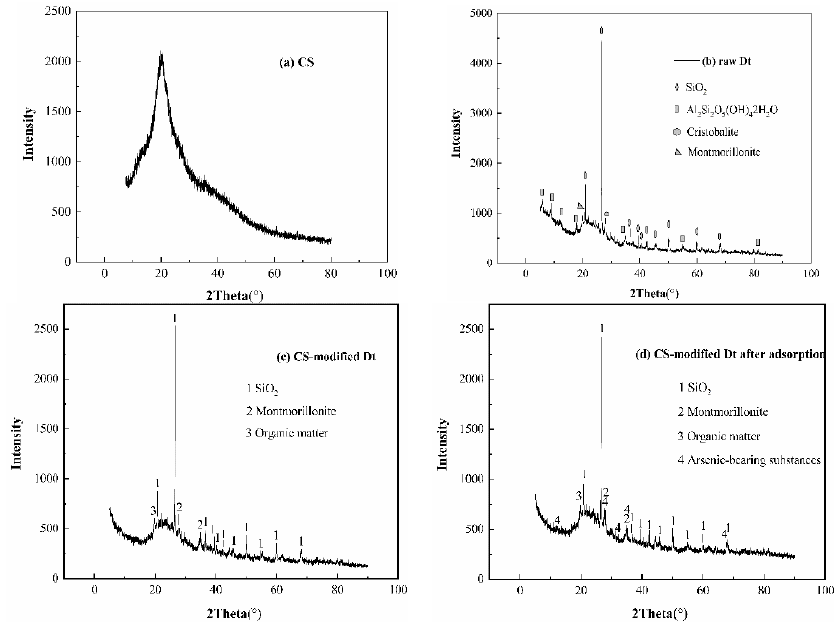
Figure7. XRDpatternsof( a )CS,( b )rawDt, ( c )CS-modifiedDt, and( d